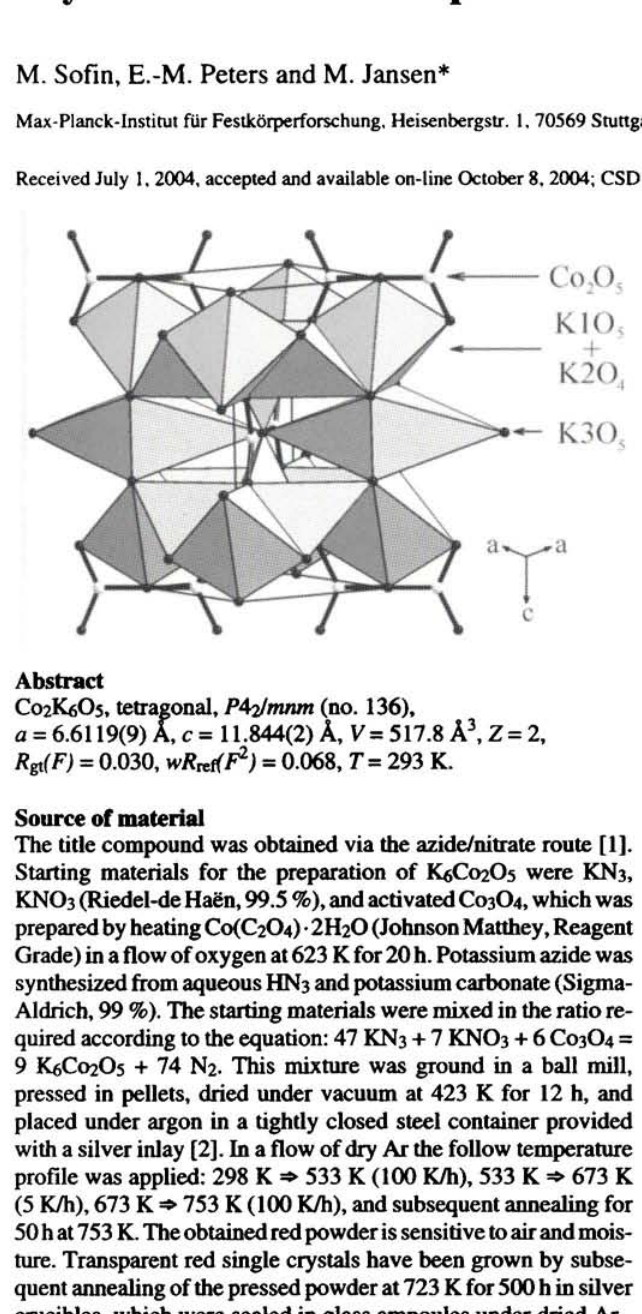
Table 2. Atomic coordinates and displacement parameters (in A 2